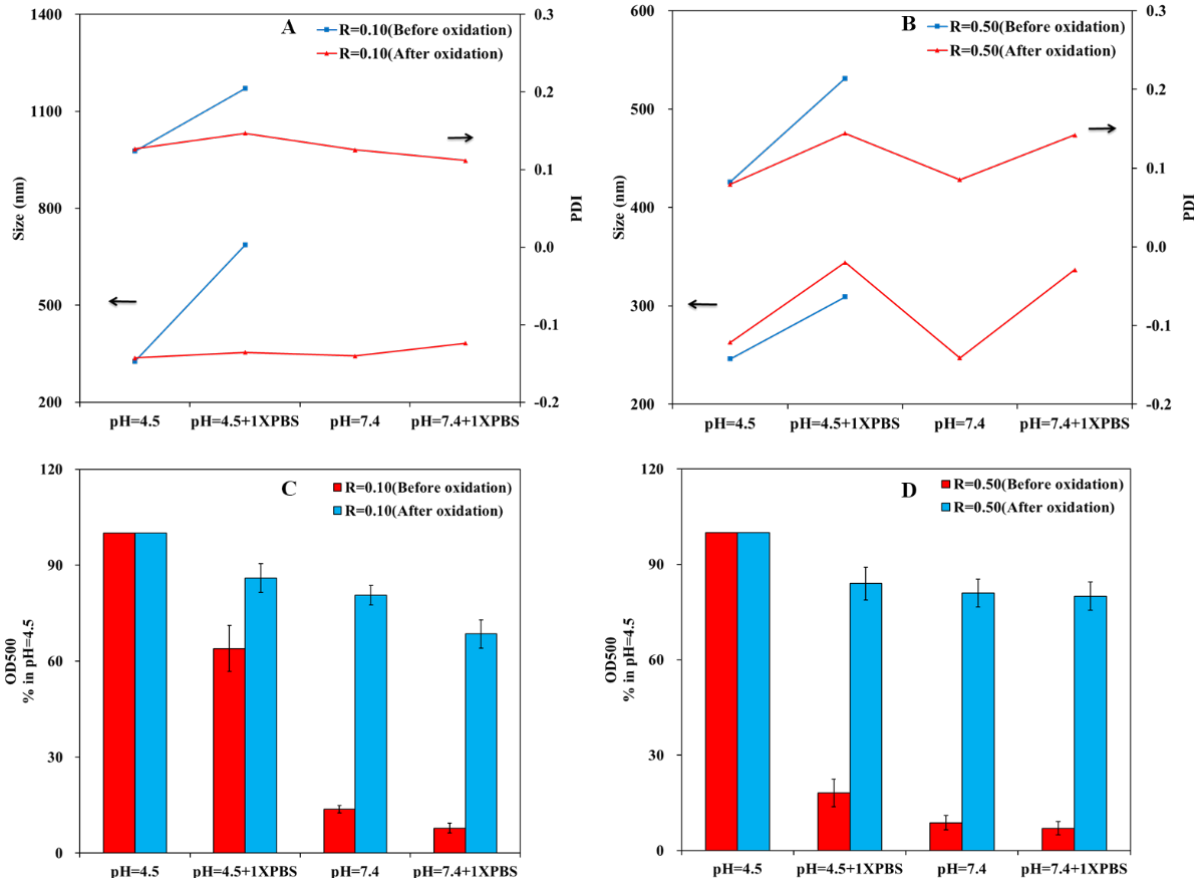
Figure 5. Physical stability of HA-SH/CH nanoparticles under different conditions before and after oxidation. ( A ) and ( C ) Negative nanoparticles (R = 0.10). ( B ) and ( D ) Positive nanoparticles (R = 0.50).